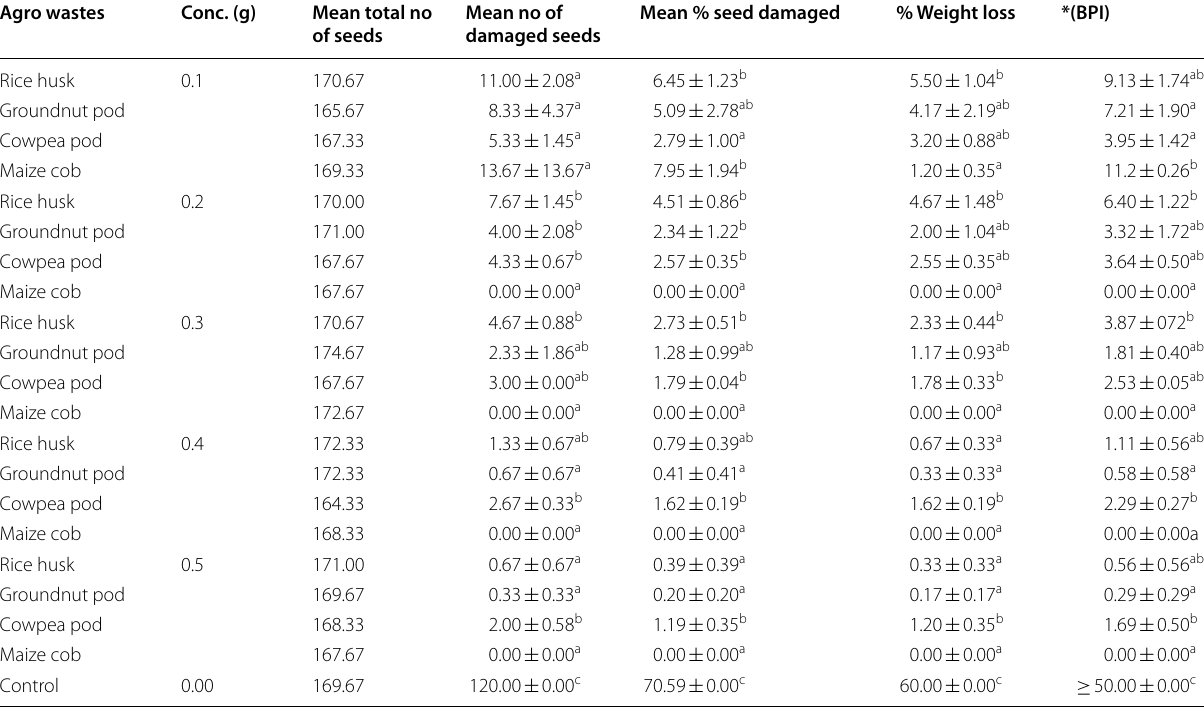
Mean followed by the same letters within the same column are not significantly different ( p >